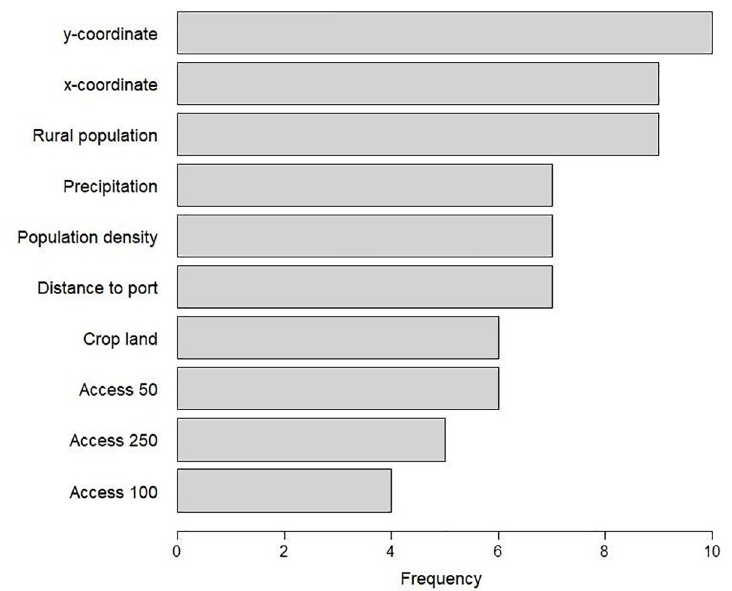
Fig 11. Variable importance across the eighteen-country level model. A variable is included if the % increase in Mean Square Error was more than 10% in a country-level Random Forest model. Access -50, -100, and -250: travel time (hours) to the nearest town with over 50,000 inhabitants, over 100,000 inhabitants, and over 250,000 inhabitants. Distance to port: travel time (hours) to the nearest